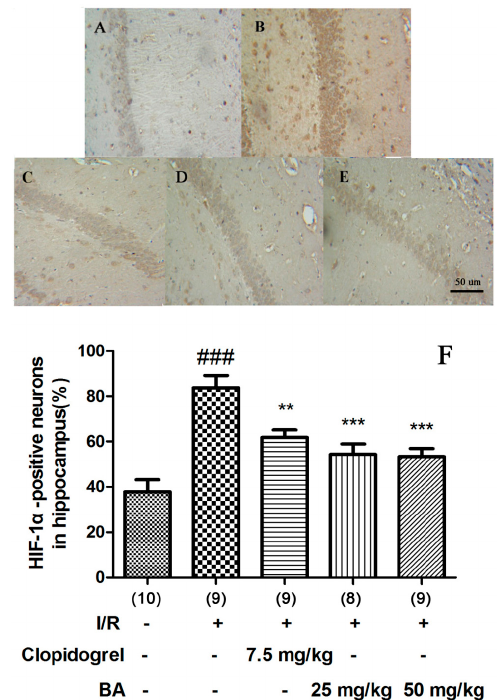
Figure 6. The influence of BA on hypoxia-inducible factor-1 α (HIF-1 α ) by immunohistochemical analysis. ( A ): sham group; ( B ): I/R group; ( C ): I/R+ clopidogrel group; ( D ): I/R+BA (25 mg/kg) group; ( E ): I/R+BA (50 mg/kg) group; ( F ): HIF-1 α positive neurons in hippocampus. Compared with sham rats (### p < 0.001) and compared with I/R (** p < 0.01, *** p < 0.001). The Arabic number in brackets represent the numbers of animals in each group.